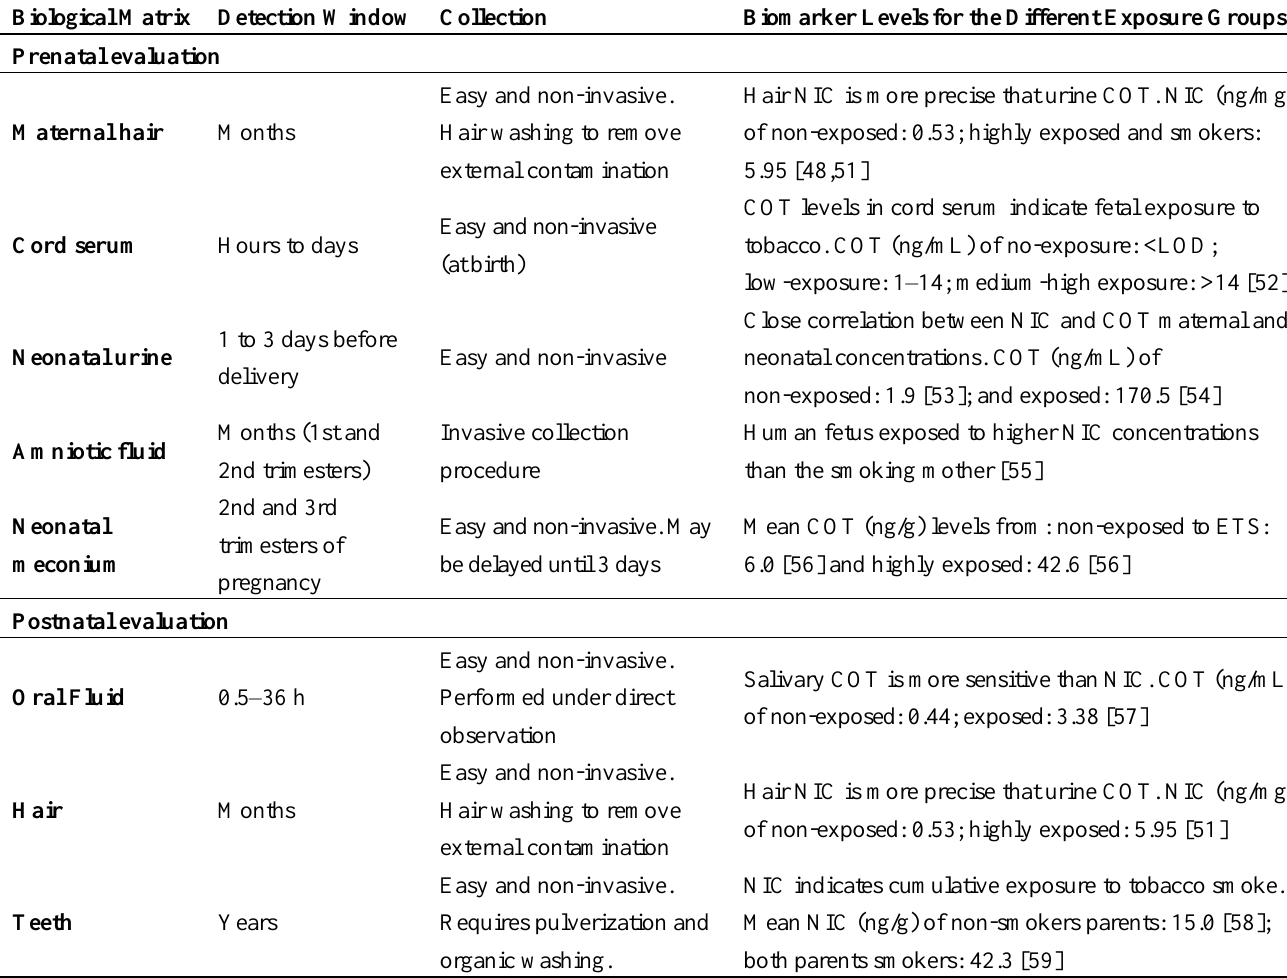
Table 1. Biological matrices for the evaluation of prenatal and postnatal exposure to environmental tobacco